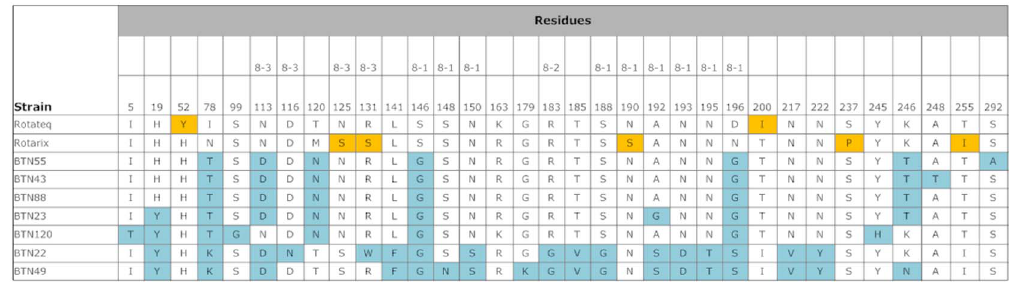
Figure 7. Comparison of the antigenic residues in the VP8* head of VP4 from RotaTeq and Rotarix, and strains circulating in Bhutan. The respective antigenic epitopes are shown above the residue numbers. The amino acid residues in Bhutanese strains that differed from those in the vaccine strains are highlighted. The amino acid residues highlighted in yellow indicate that the residue is different from the other vaccine strain and Bhutanese strains. BTN-22 and BTN-49 belong to lineage 4 of genotype P[8].